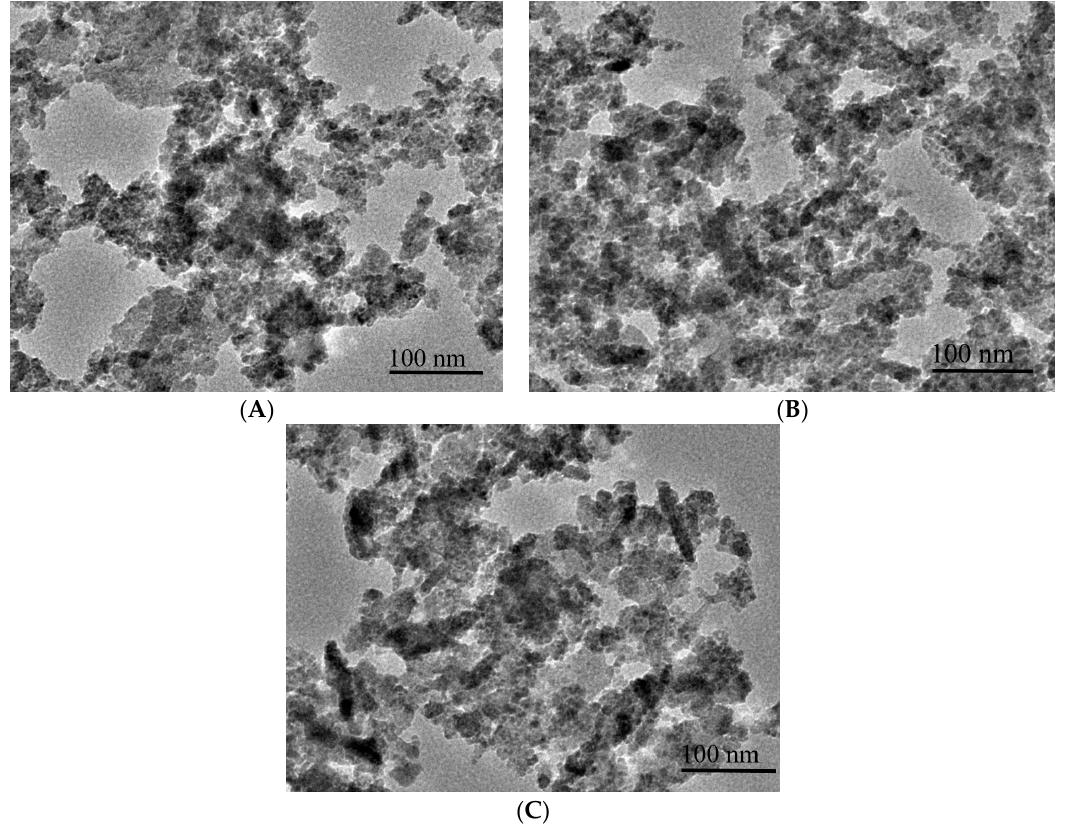
Figure 2. Transmission electron microscopy (TEM) images of: Mn/MCS ‐ R ( A ); Mn/MCS ‐ I ( B ); and Mn/MCS ‐ H ( C ).